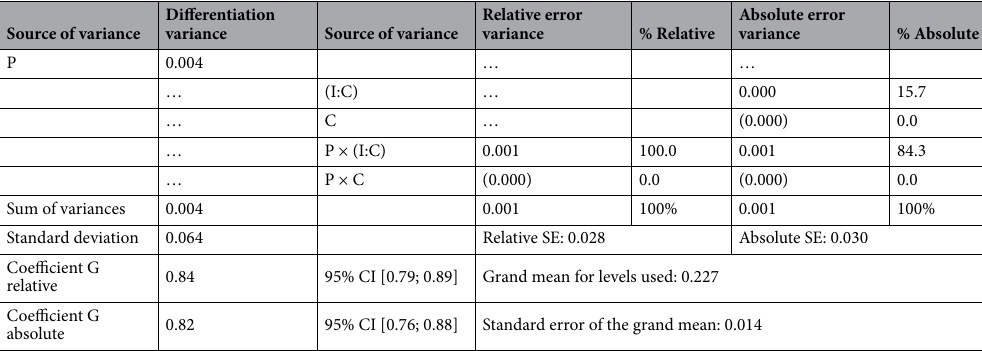
Table 1. G-study estimates for the Stroke Riskometer including standard errors (SE), grand mean (GM), standard error of the grand mean, Coefficient G relative (Gr), Coefficient G absolute (Ga), and variance components for the design of P × (I:C) (n =